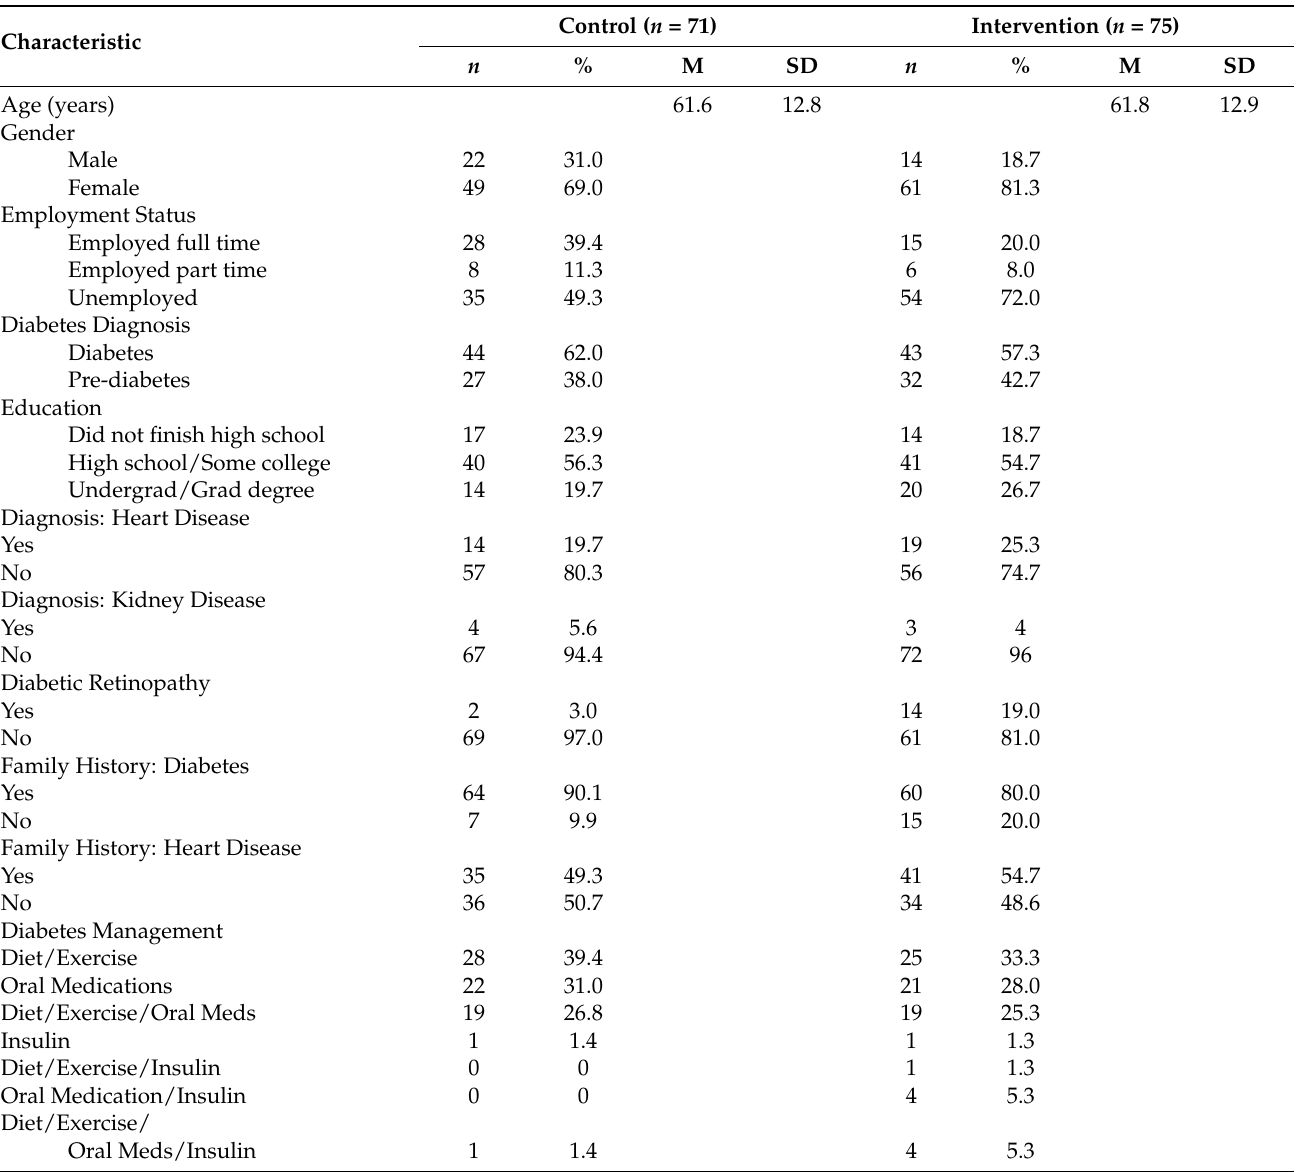
Table 1. Sociodemographic